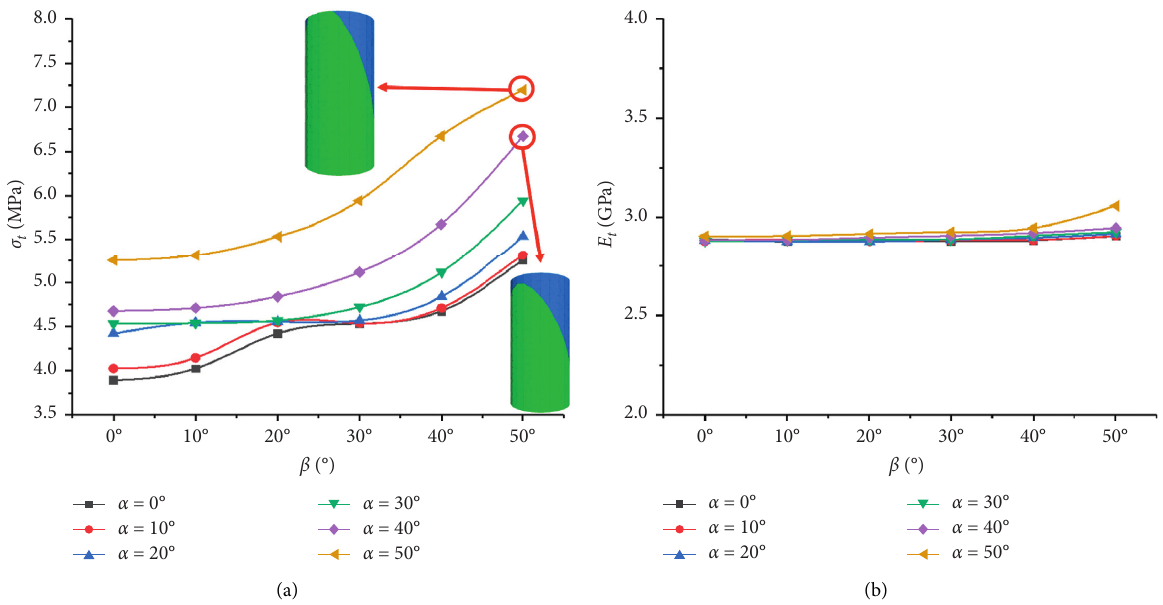
Figure 6: Variation in mechanical behavior of specimens with joint angles. (a) σ